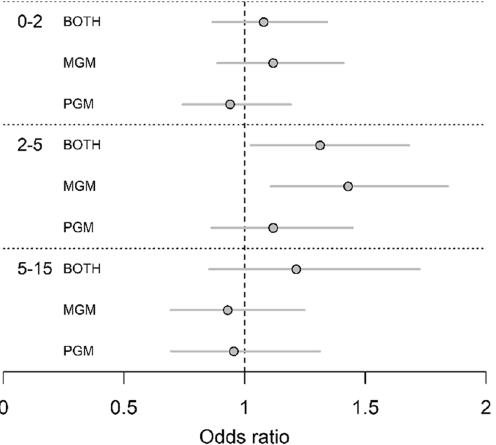
Figure 3. Odds ratios of grandchild survival by grandmother presence for each age class. MGM maternal grandmother alive, PGM paternal grandmother alive. Lines for each value are 95% confidence intervals. Vertical dashed line indicates an odds ratio of 1; an overlapping odds ratio indicates there is no meaningful difference in survival compared to the baseline of having no living grandmother. All models controlled for mother survival status. Age class 0–2 additionally controlled for sex, whether the focal individual was a twin, social class, and region of Finland, and age class 5–15 controlled for number of living siblings.